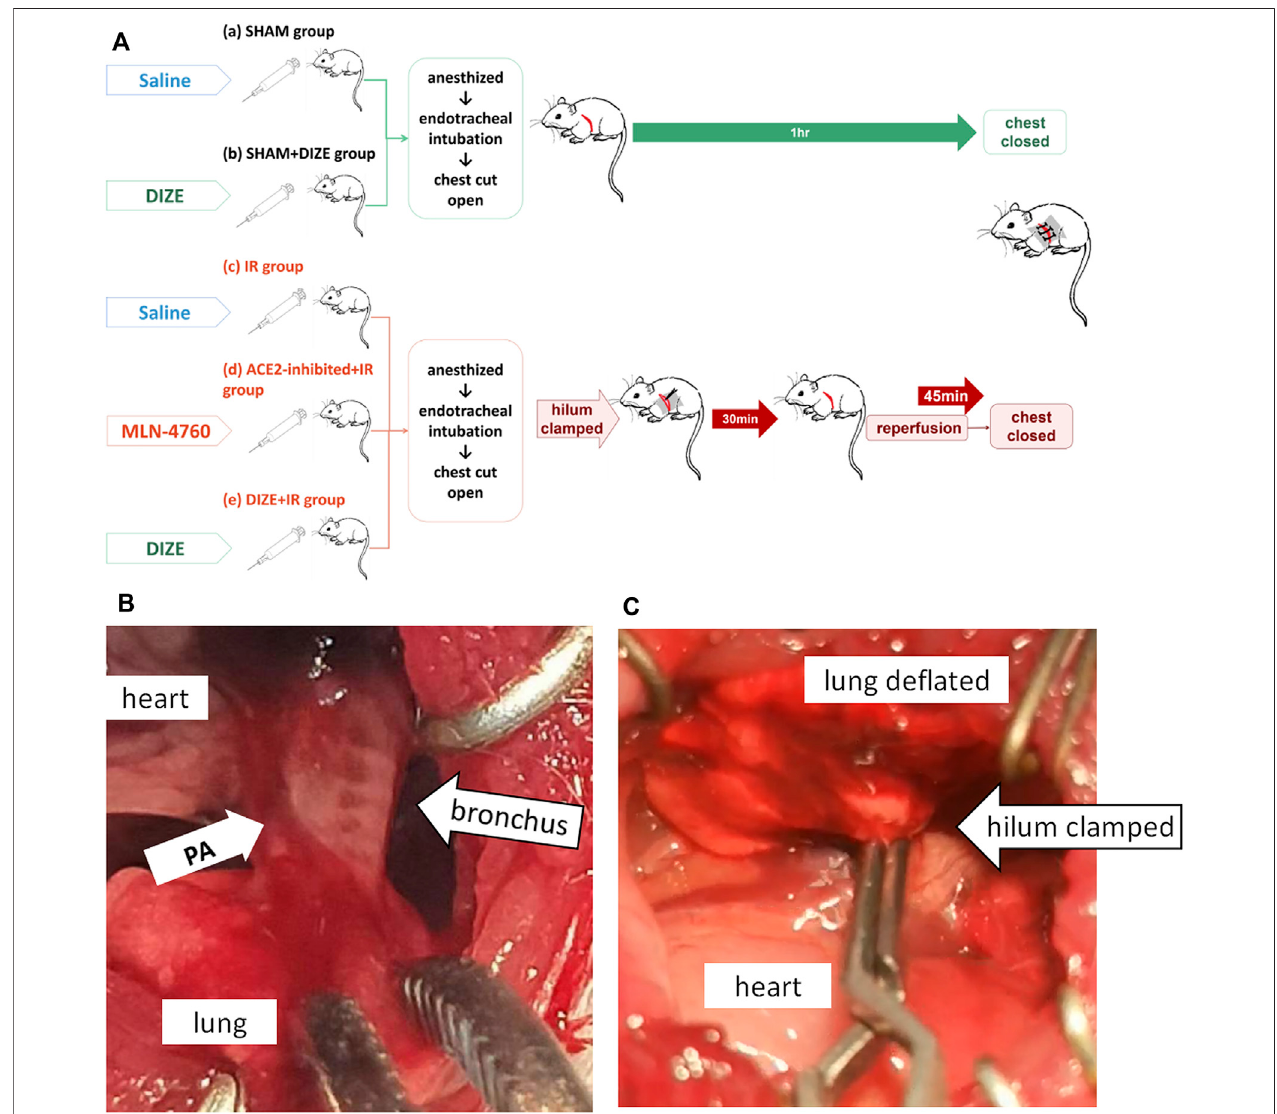
FIGURE2| Lung ischemia-reperfusion experimental procedures. (A) Animals wererandomized into fi ve groups: the SHAM group , SHAM +DIZE group , IR group , IR+ACE2-inhibitedgroup ,and IR+DIZEgroup .Forthe IR+DIZE and SHAM+DIZEgroups ,0.1%DIZE15 mg/kg/daywasinjectedintreperitoneally.Forthe IR+ACE2- inhibited group , a potent ACE2 inhibitor, MLN-4760 was injected via the caudal vein before surgery. For the IR group , IR + ACE2-inhibited group and IR + DIZE group , a lung IR injury model were established. For the SHAM and SHAM + DIZE groups , only tracheotomy, mechanical ventilation and open chest operation were performed. (B) The key procedure during the surgery was to fi nd the bronchus accompanied by the pulmonary artery. (C) The lung de fl ated when the hilum was clamped.